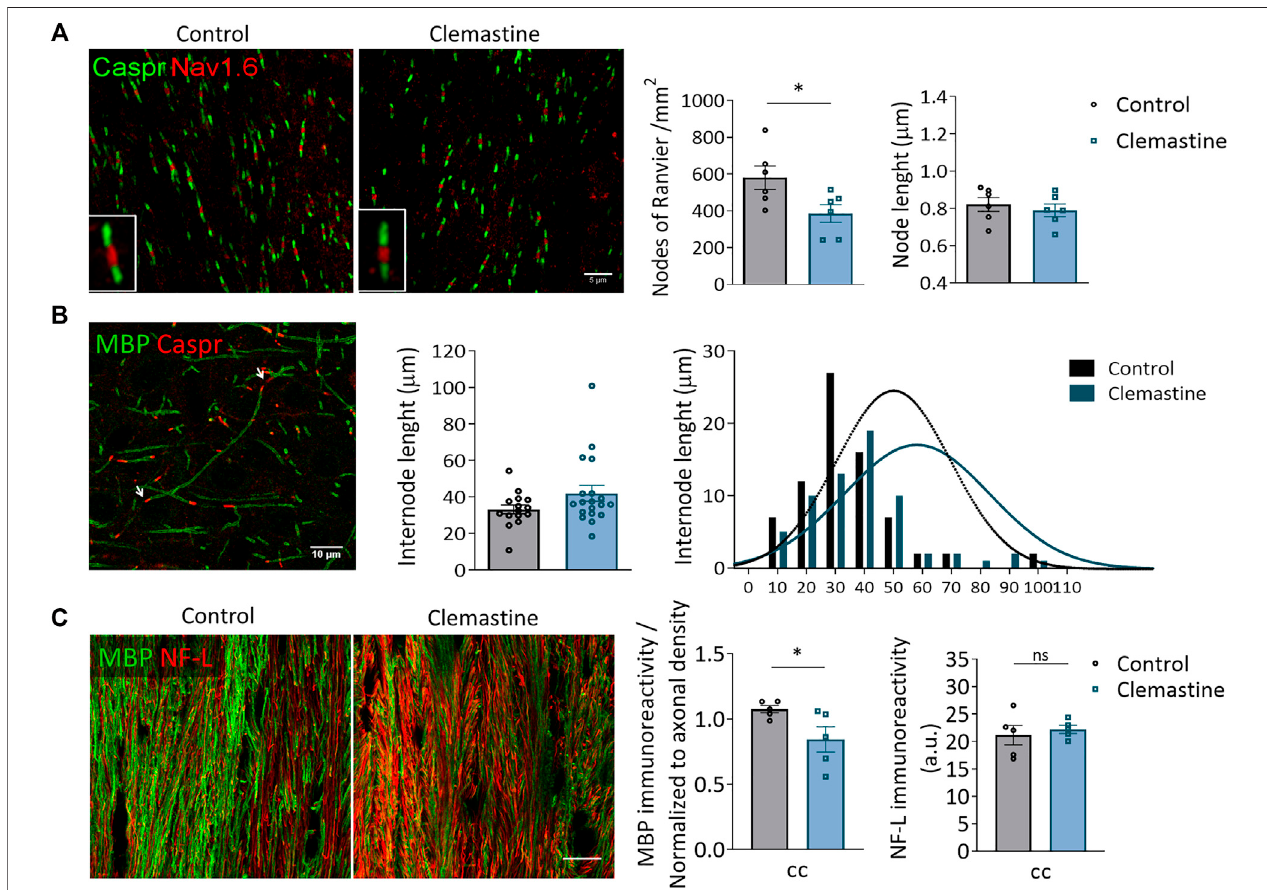
FIGURE 3 | (A) Representative confocal images of nodes of Ranvier (Na v 1.6; red) and paranodes (caspr; green) in corpus callosum of control and clemastine treatedP21mice.Scalebar=5 μ m.Rigth,histogramsshowsaveragenodeofRanviernumberandlengthincontrolandclemastine-treatedmice( n =6 per experimental group). (B) Representative confocal images of MBP + myelin internodes (green) fl anked by two caspr + paranodes (red; arrows). Right , average and cumulative internode length distribution in cerebral cortex of control and clemastine-treated P21 mice ( n = 6 per group). (C) Representative confocal images of MBP and Neuro fi